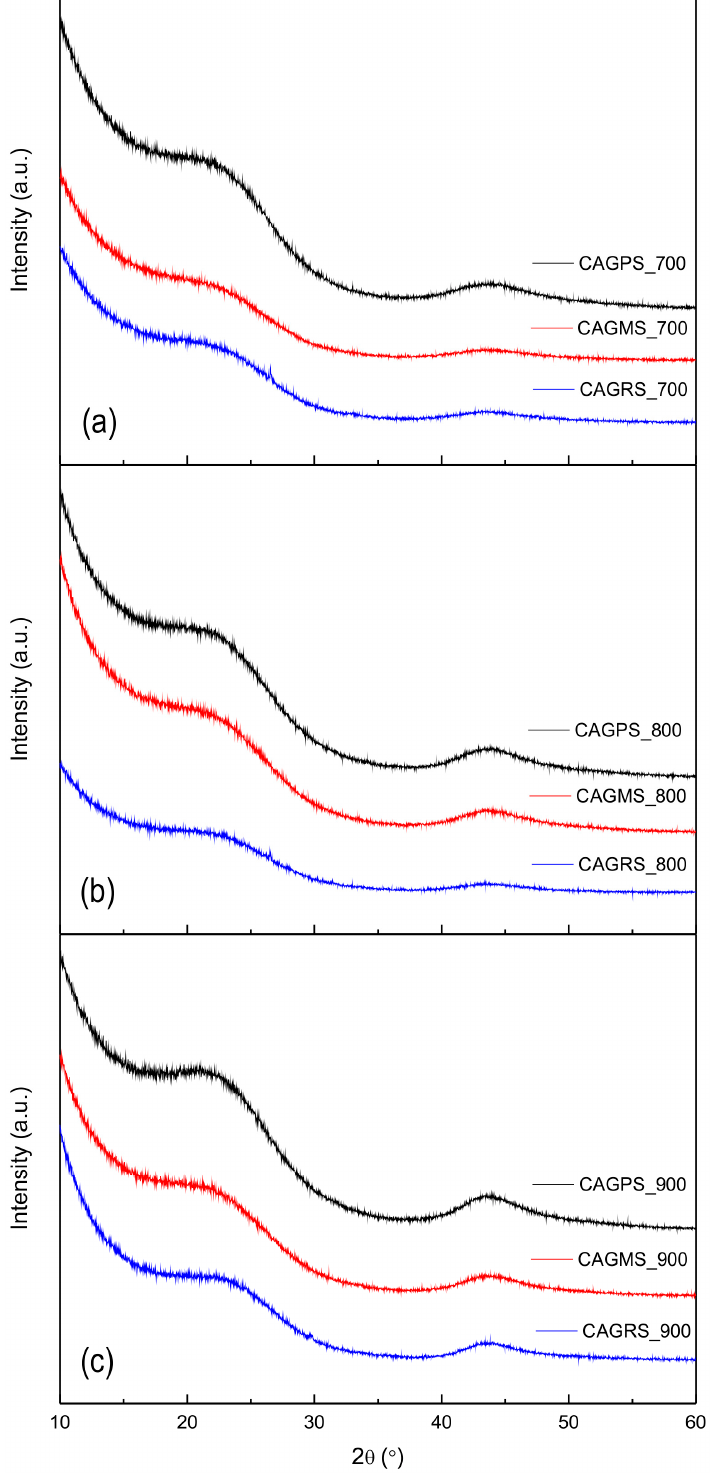
Figure 4. X-ray diffraction patterns of carbon aerogels pyrolysed at ( a ) 700 °C; ( b ) 800 °C and ( c ) 900 °C.